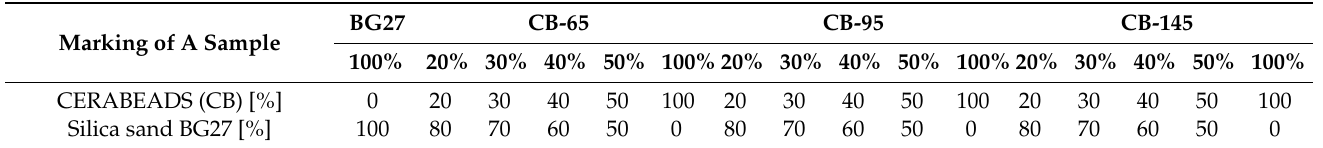
Table 1. Marking of samples according to their